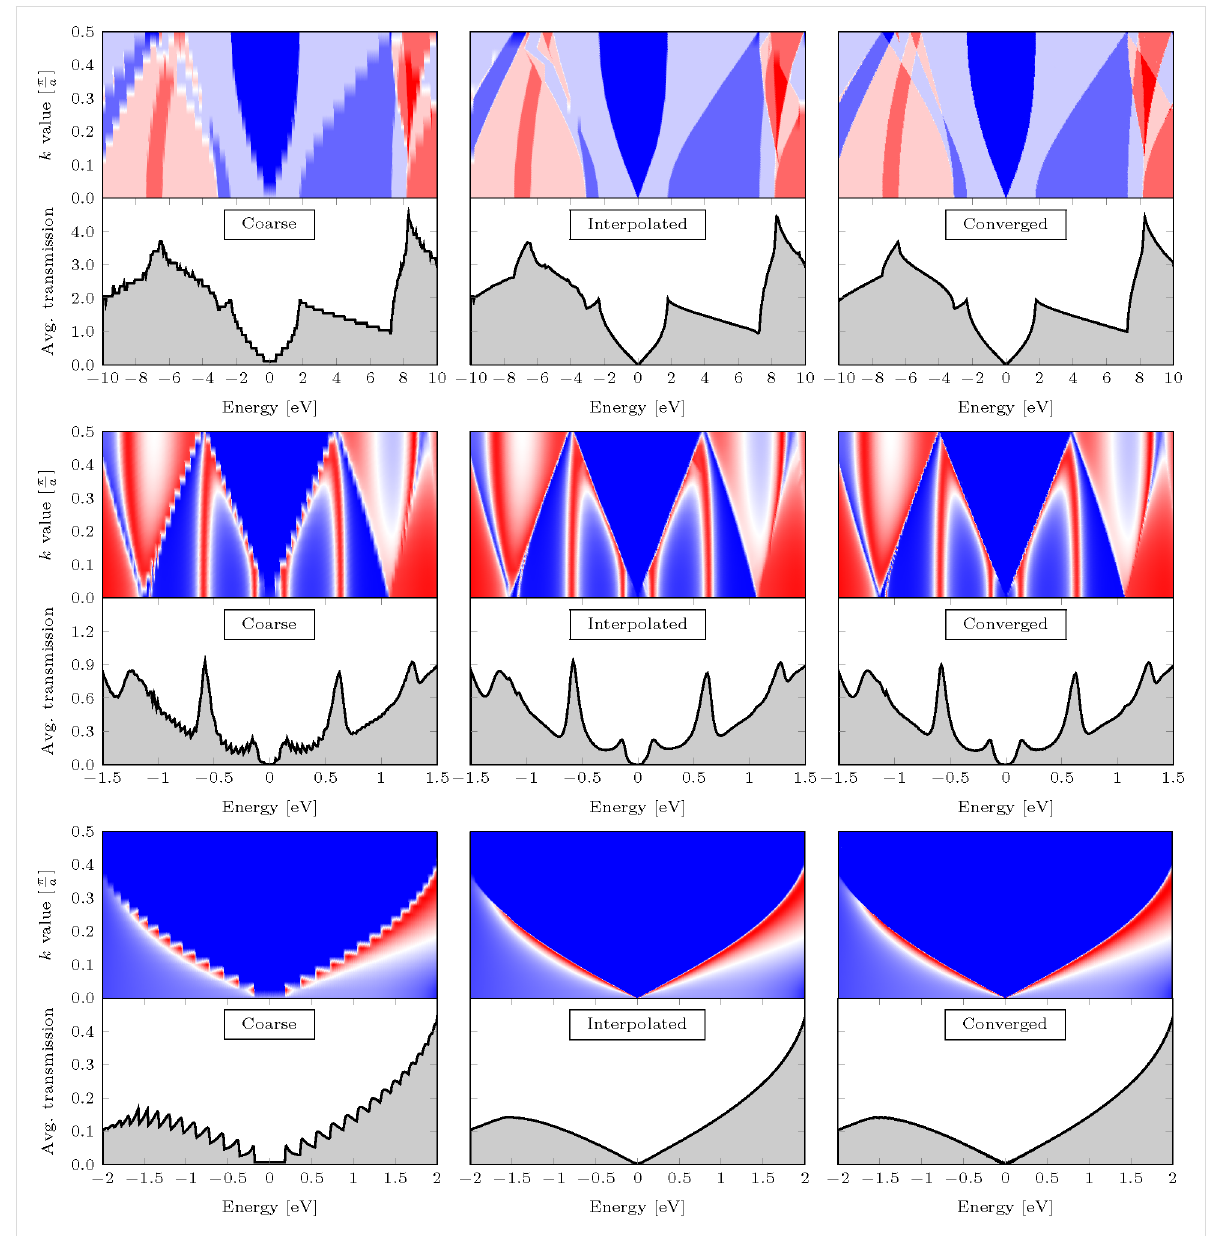
Figure 4: Algorithm applied to raw transmission data for the graphene-based systems in Figure 3. The raw data (left column) is interpolated (middle column) and compared to the fully converged transmission curve (right column). The upper window of each subfigure is the full transmission for each k -value, while the lower window shows the averaged